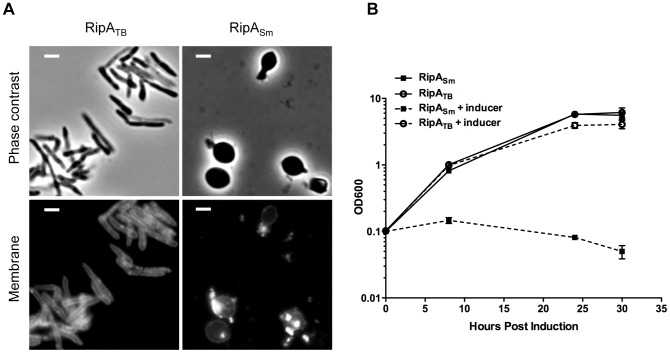
RipA is differentially active in a species-specific manner.(A) Fluorescence micrographs of M. smegmatis strains induced with aTc to overexpress M. tuberculosis RipA (RipATB) or M. smegmatis RipA (RipASm). Membranes were stained with TMA-DPH. Scale bar represents 2 µm. (B) M. smegmatis strains in (A) were induced with aTc to overexpress RipATB and RipASm constructs. Growth of these strains was monitored over time by OD600.